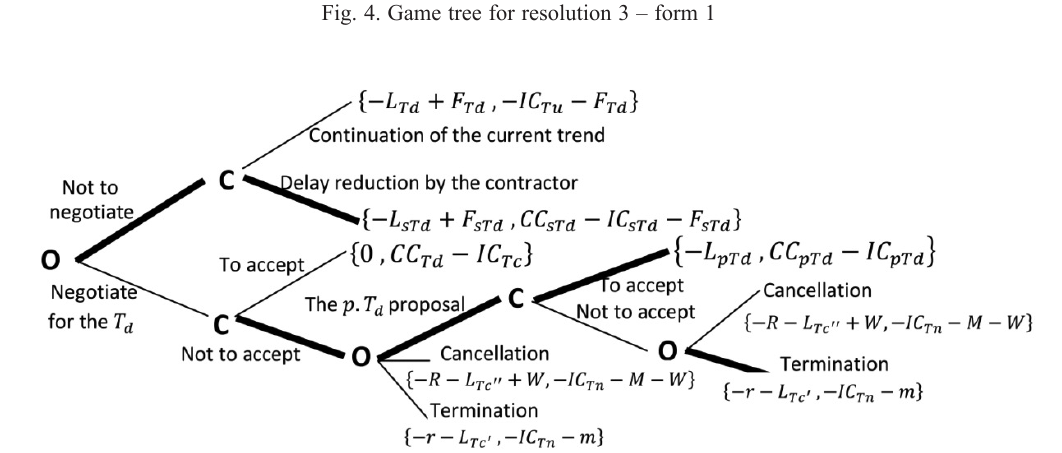
Fig. 4. Game tree for resolution 3 – form 1